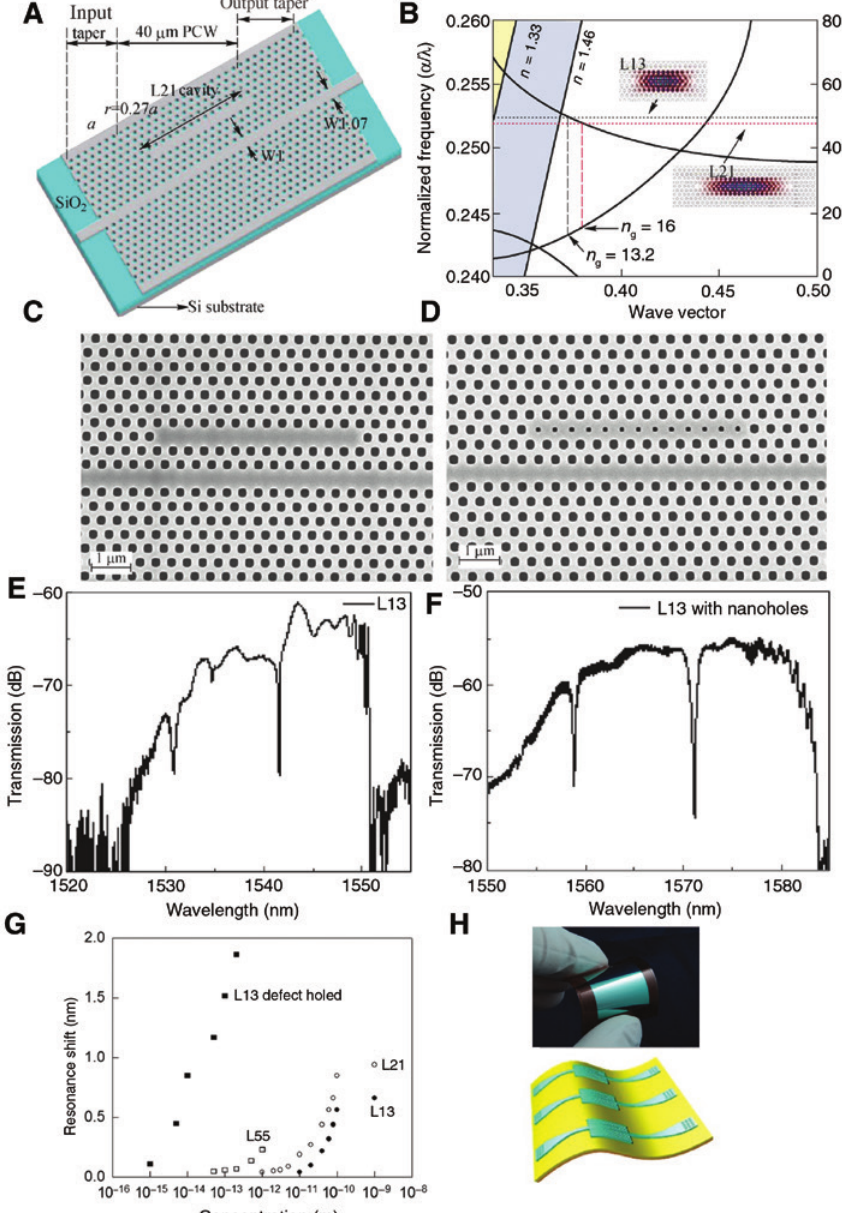
Figure 21: Photonic crystal defect cavity based sensors. (A) Schematic of one of the PhC microcavity devices for biosensing. (B) Dispersion diagram of a W1 PhC waveguide in water. The black and red dashed lines indicate the frequencies of resonant modes for L13 and L21 PhC microcavities. The mode profiles are given as insets. Adapted from [183]. (C)–(F) SEM images of a L13 PhC microcavity with and without nanoholes. Their transmission spectra with a number of sharp resonances are found below them. Adapted from [183] and [184]. (G) Biosensing spectral shifts in L21, L55, L13, and L13 defect holed PhC microcavities. Adapted from [185]. (H) Flexible silicon nanomembrane PhC microcavity (i.e. 2 cm × 2 cm nanomembrane) on polyimide film and a schematic of the film peeled off from the mechanical support. Adapted from